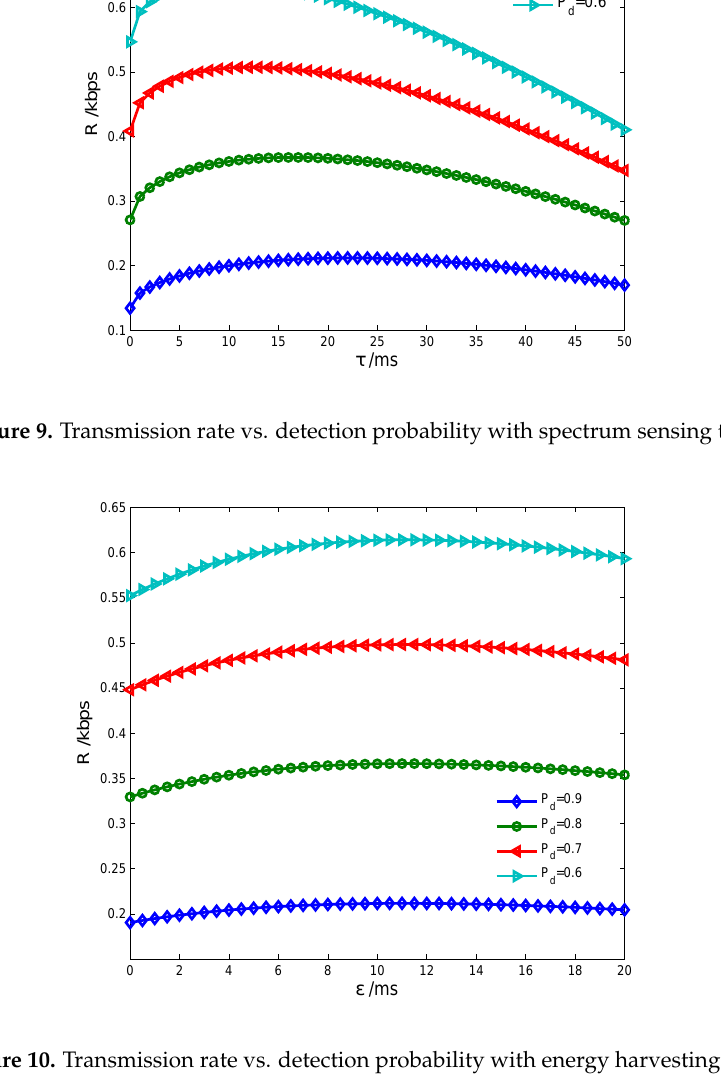
Figure 10. Transmission rate vs. detection probability with energy harvesting time. Figure 11 indicates the transmission rate of the CS vs. the proposed energy-harvesting-based CS model and the traditional CS model without energy harvesting [10]. We can see that the proposed energy-harvesting-based CS model results in a higher transmission rate than the traditional CS model, which indicates that energy harvesting can improve the transmission performance